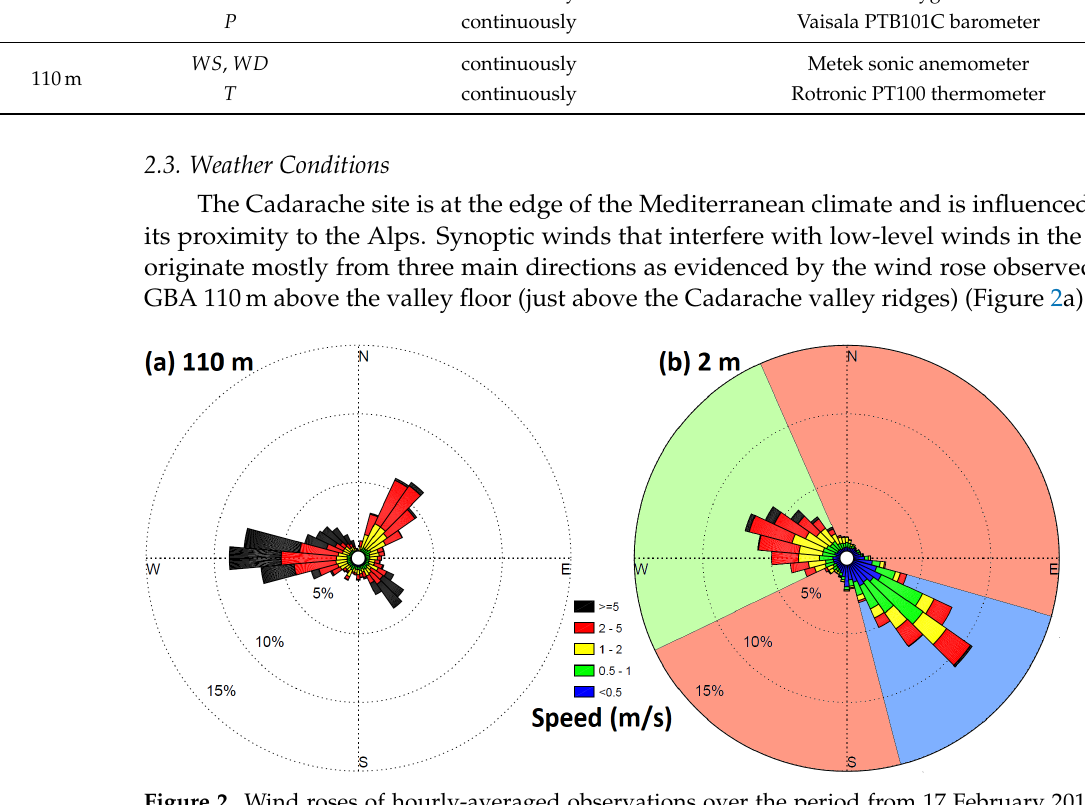
Figure 2. Wind roses of hourly-averaged observations over the period from 17 February 2015 to 17 February 2016 at ( a ) 110m at GBA and ( b ) 2m at MET01. The colored sectors in subfigure (b) correspond to the classification used in this paper (see Section 4.2): the blue sector for the Cadarache down-valley (CDV) winds extends from 105° to 165°, the green sector for the Cadarache up-valley winds extends from 245° to 335°, and salmon sectors include all other directions, corresponding to transverse winds. After Dupuy et al.